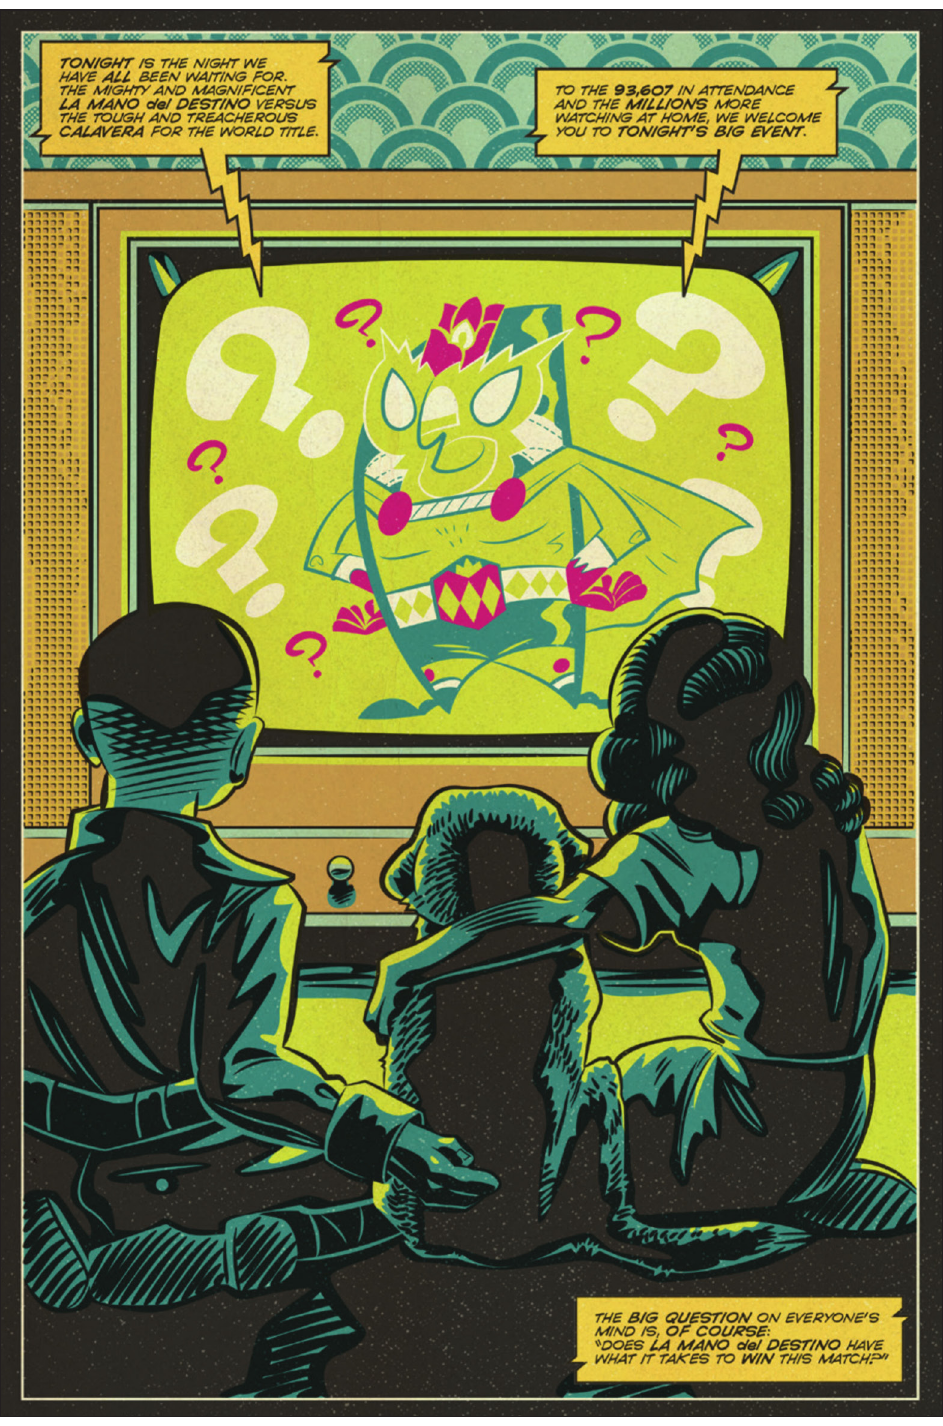
Figure 2 UPA stylization in